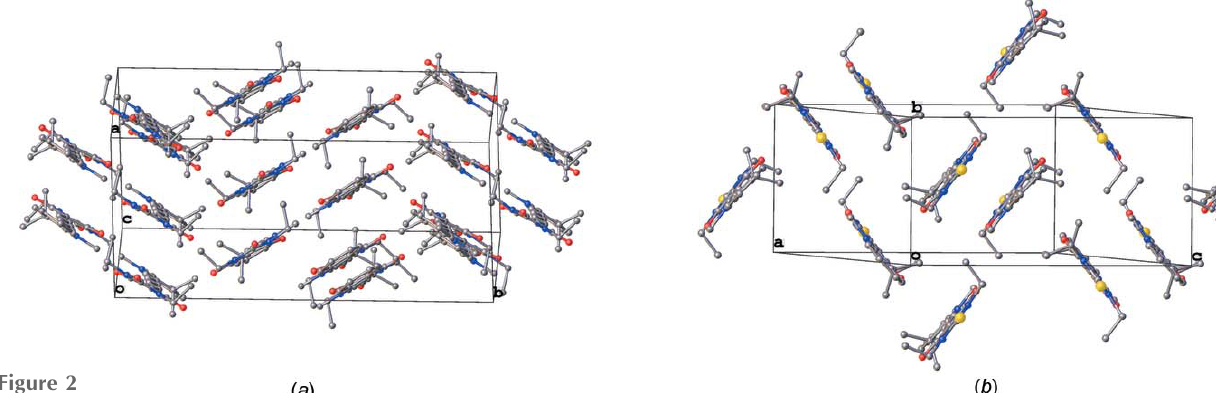
Figure 2 The molecular packing in the crystals of compounds ( a ) TMI and ( b ) DTB.